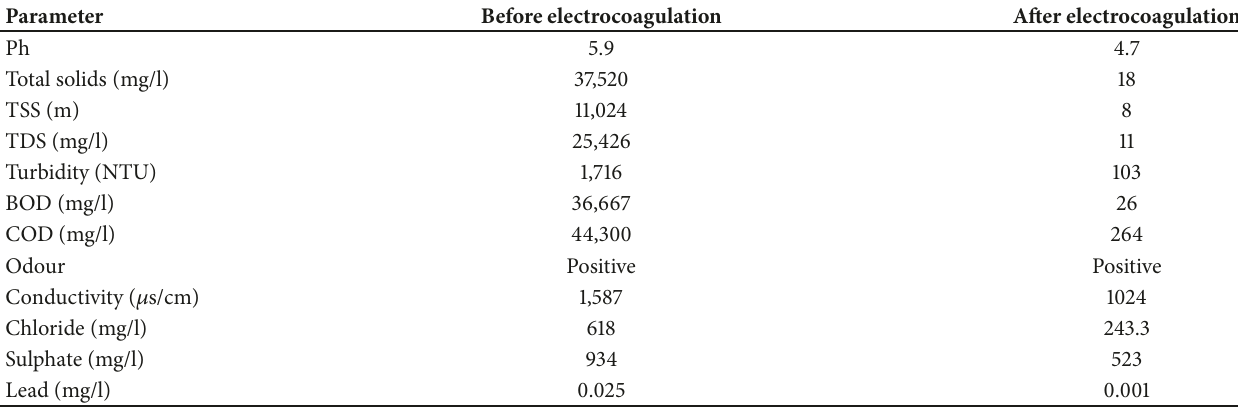
Table 1: Characterization result of POME before electrocoagulation and after electrocoagulation at optimum conditions of 3 Amps, 60min, pH of 10, and 30 ∘ C.